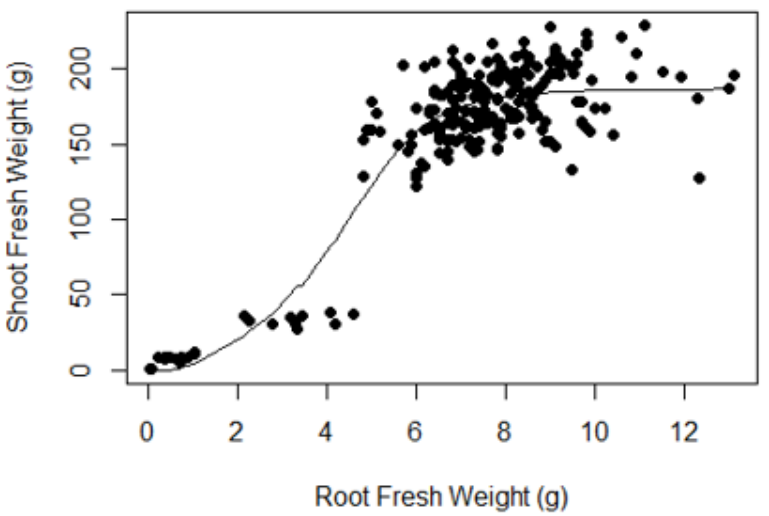
Figure 4. Gompertz growth curve of shoot fresh-weight vs. root fresh weight.